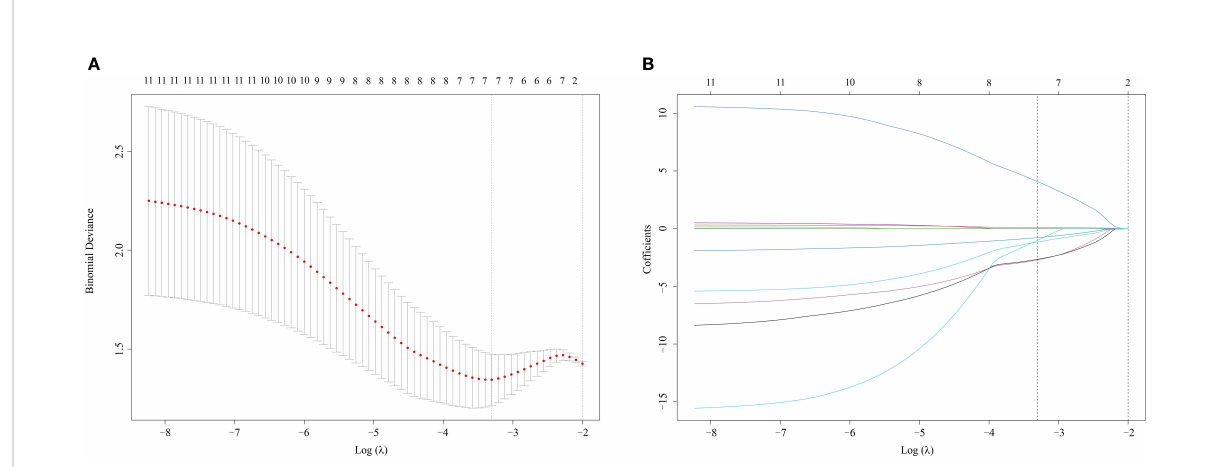
FIGURE 3 Radiomics selection using LASSO logistic regression model (A) . The tuning parameter l selection of LASSO model with 10-fold cross-validation was performed to select radiomic features. At the optimal tuning parameter l value of 0.036 and log ( l ) = -3.322, the left dotted vertical line was set with the minimum criteria where 7 radiomic features were selected. (B) . LASSO coef fi cient pro fi le of 11 Radiomic features. A coef fi cient pro fi le plot was generated against the log ( l ) sequence. The dotted vertical lines were drawn at the 6 non-zero coef fi cients, with the optimal value of l . LASSO, least absolute shrinkage and selection